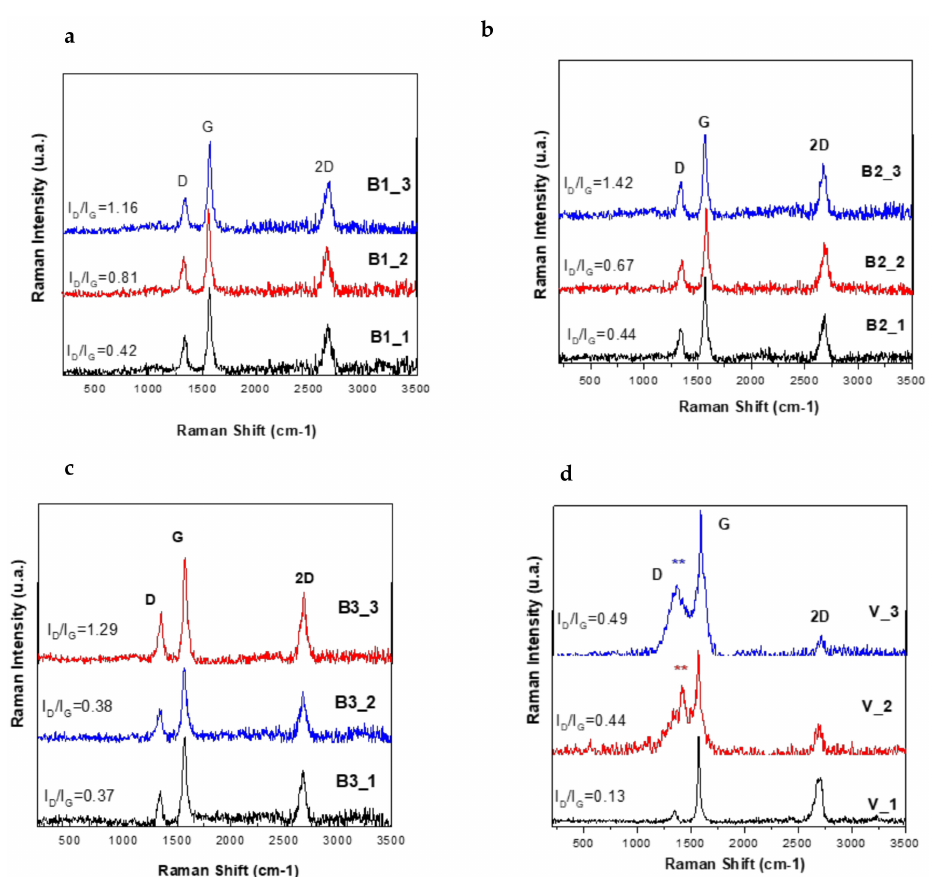
Figure 7. Raman spectra of 1, 2 and 3 layers of ( a ) B1 ( b ) B2, ( c ) B3 and ( d ) V